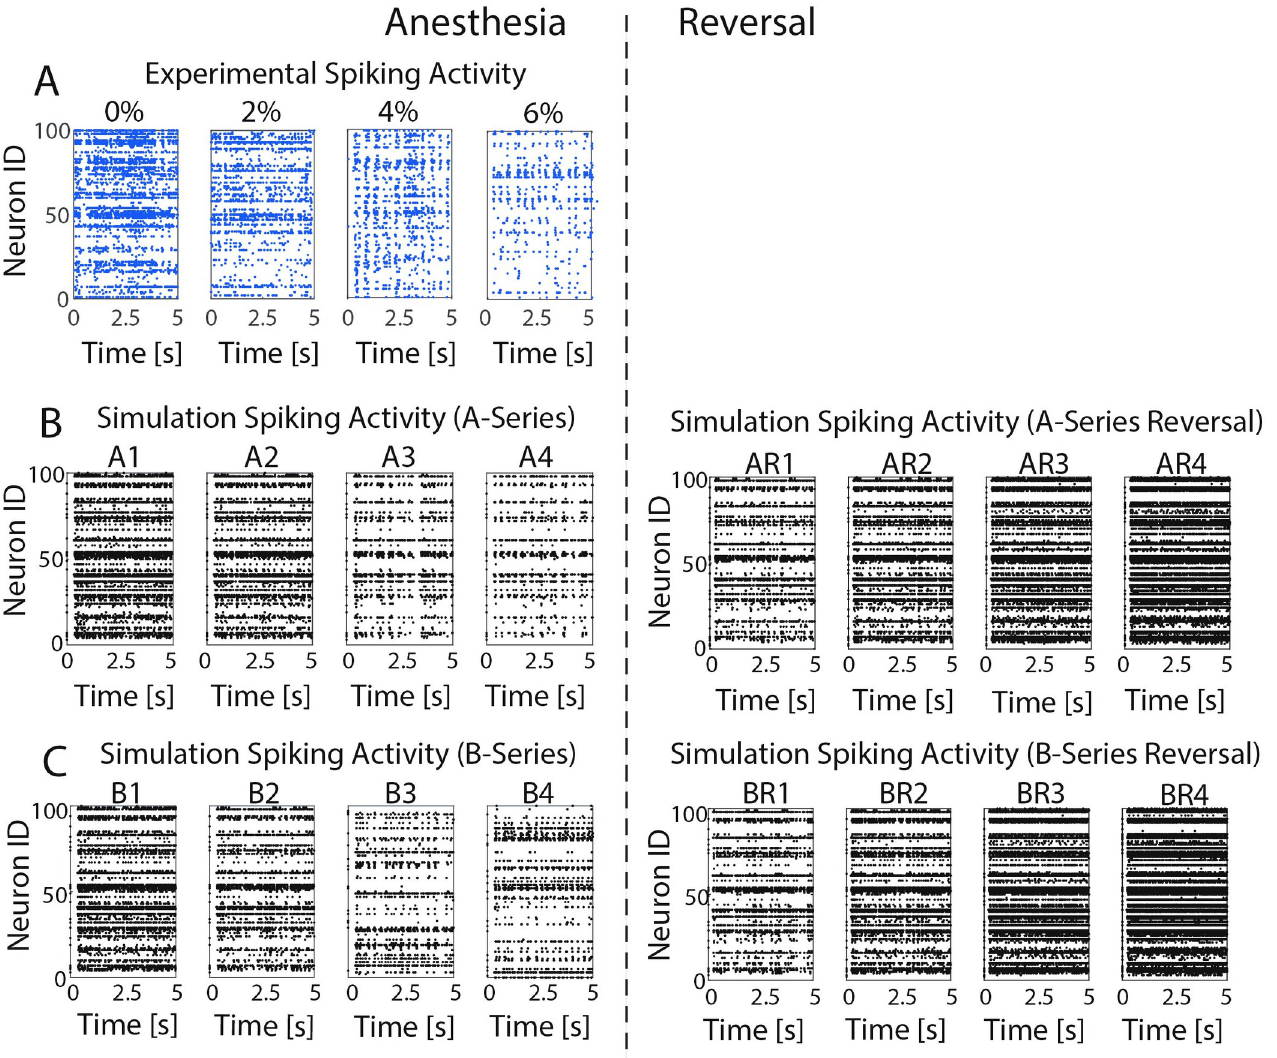
Fig 2. Changes in anesthesia level lead to transitions from high frequency asynchronous to low frequency synchronous spiking patterns. A). Raster plots of experimentally recorded neuronal activity in response to changes in desflurane levels. For higher concentrations of desflurane ( 6% ), oscillatory synchronous network activity can be seen in spiking dynamics. For lower levels of anesthetic, oscillations are not apparent and asynchronous activity dominates. B) Raster plots for simulated anesthetic effects in optimized model networks for constant g Ks (A-Series) and the simulated ACh-induced reversal of anesthetic effects (A-Series reversal). C) Raster plots for simulated anesthetic effects in optimized networks with changing g Ks (B-Series) and its reversal (B Series reversal). In both B) and C), simulated anesthetic reversal shows reinstatement of asynchronous from synchronous spiking patterns. Simulation results based on best fit parameters (lowest cost optimization when averaged across anesthesia